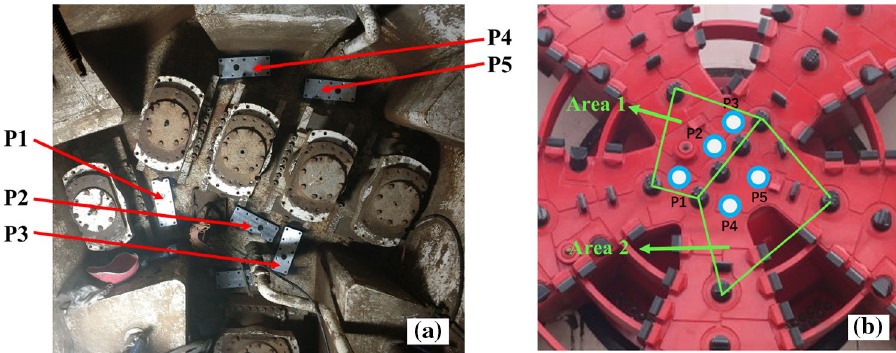
Figure 8. Sensors installed position of the cutterhead: ( a ) reverse side of cutterhead, ( b ) front side of cutterhead.